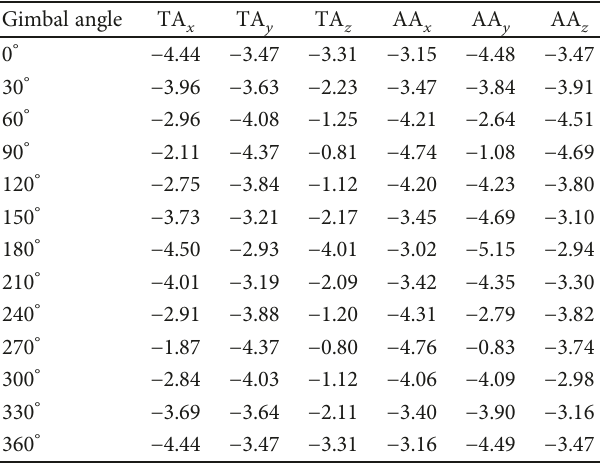
Table 6: Simulation error of the dynamic response on the DSM (%). Gimbal angle TA